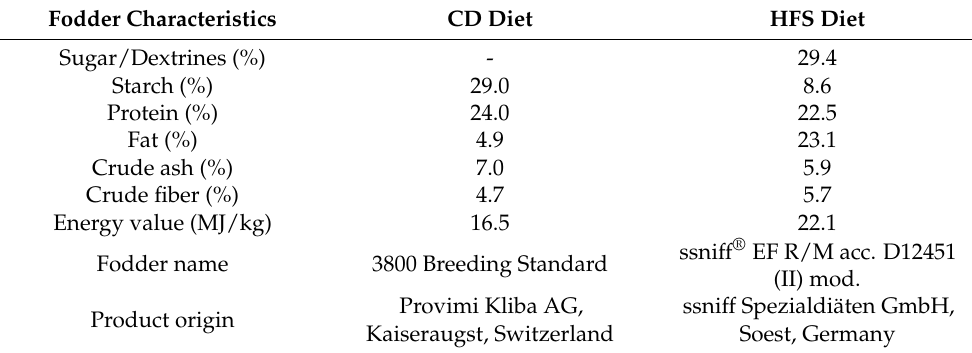
Table 1. Characteristics of control (CD) and high-fat/high-sugar (HFS) diets fed to Sprague-Dawley rats included in to the